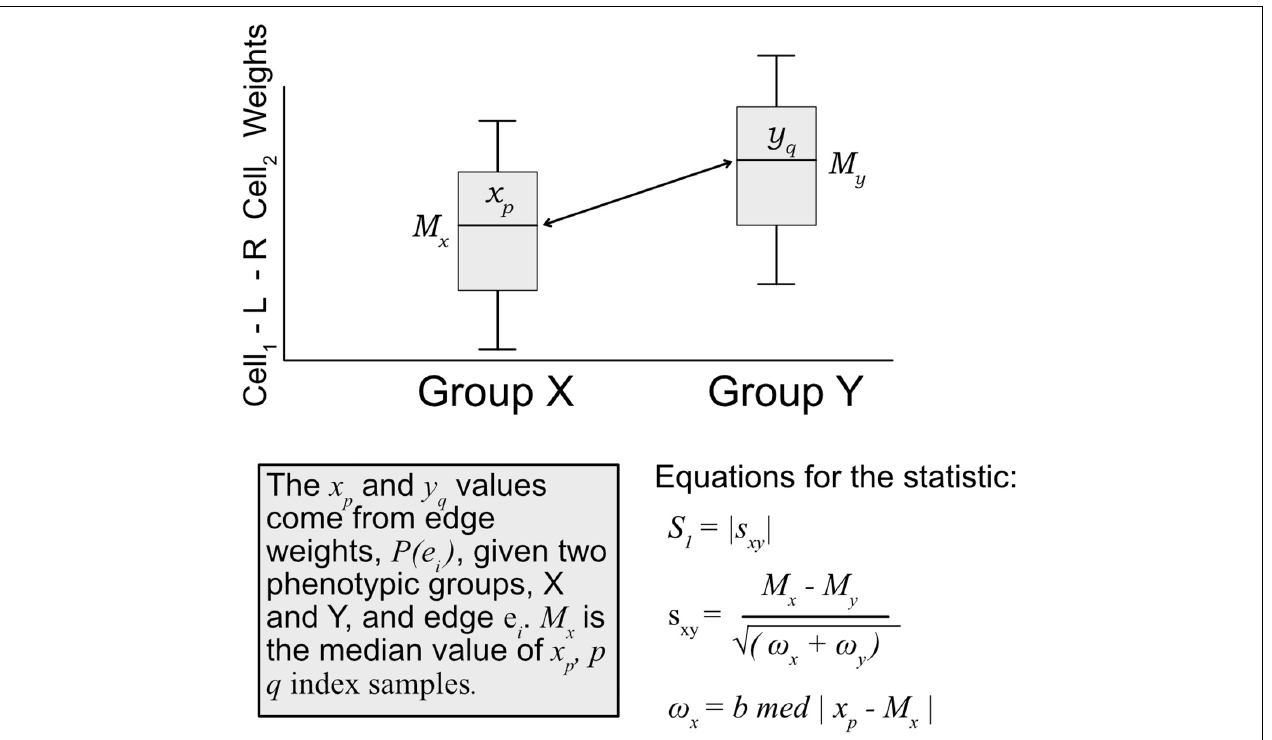
FIGURE 3 | Diagram of how the S 1 statistic is calculated. Given two groups and one edge of interest, the statistic is generated using edge weights as input. For each group, both the median and maximum absolute deviation of edge weights are calculated and used to compute the S 1 . The resulting robust statistic describes the magnitude of difference between groups for one